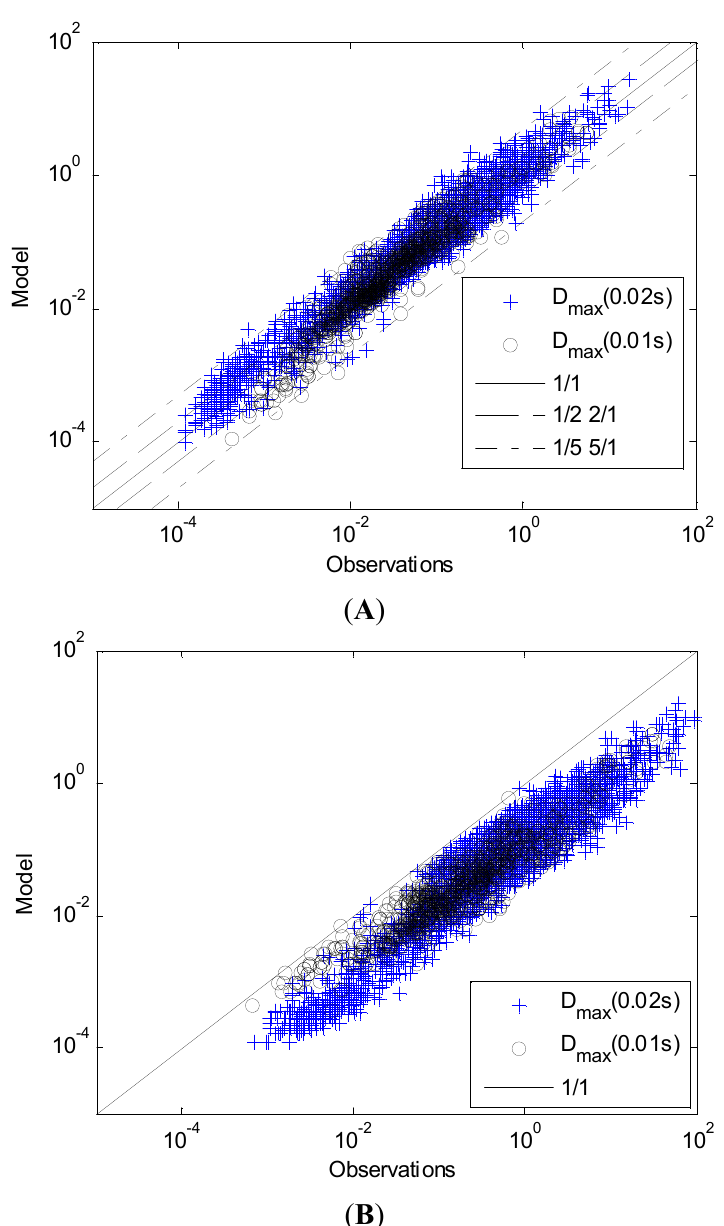
Figure 2. Performance of Bartzis et al. (2008) [12] model for β = 1.72 ( A ) and β = 12.46 ( B ) ( Δτ = 0.01–0.02